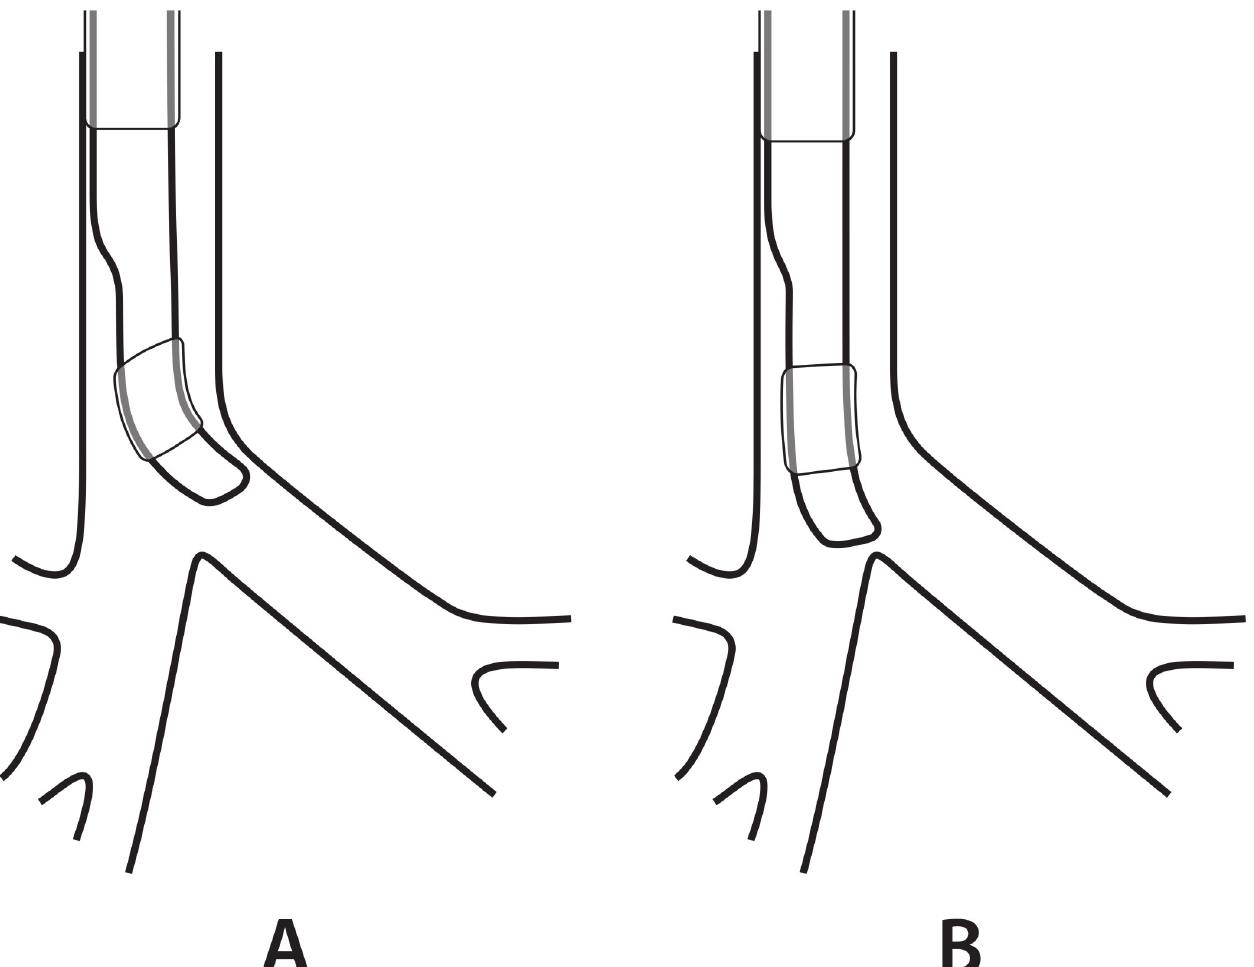
Fig 6. A diagram showing that the more curved tip of the left-sided double-lumen tube (A) is further extended to the left bronchial opening over the carina compared with the less curved tip